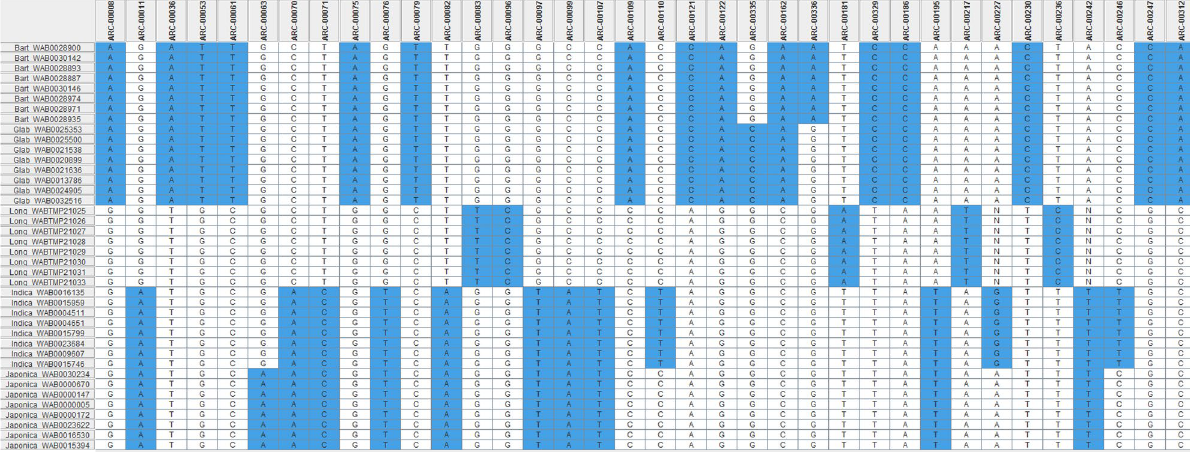
Figure 2. Haplotype pattern of 36 diagnostic SNP markers recommended for “broad” quality control genotyping between O. barthii and O. glaberrima (2 SNPs), between the two African species O. barthii / O. glaberrima and the complex O. sativa and O. longistaminata (16 SNPs), between the Asian rice O. sativa and the three African species O. barthii / O. glaberrima / O. longistaminata (9 SNPs) , between O. longistaminata and O. barthii/O. glaberrima and O. sativa (5 SNPs) , between lowland O. sativa spp . indica and the complex Upland O. sativa spp . japonica/O. barthii/O. glaberrima/O. longistaminata (3 SNPs), and between Upland O. sativa spp . japonica and the complex lowland O. sativa spp . indica/O. barthii/O. glaberrima/O. longistaminata (1 SNPs). Each species or ecotype is represented by eight randomly selected accessions, which are listed in rows on the left side with prefix (Bart O. barthii , Glab O. glaberrima , Long O. longistaminata , Indica O. sativa spp. indica , japonica O. sativa spp. japonica ), followed by accession number. The SNP IDs are listed as column headings. Each column has two alleles that are shaded either in white or blue. See Supplementary Table S2 for details on accessions, Supplementary Table S1 for SNP summary.